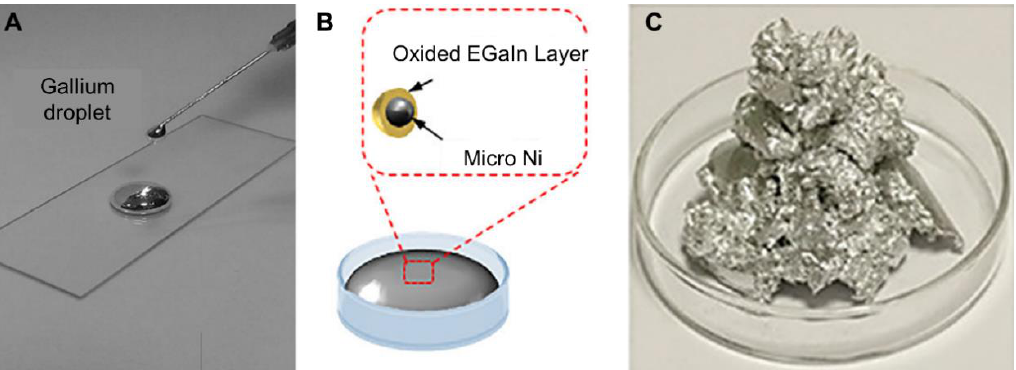
Figure 1. Liquid metal and its mixture. ( A ) Photo of gallium droplet, reproduced with permission from [69]. ( B ) Schematic diagram of Ni-GaIn particle, reproduced with permission from [70]. ( C ) Photo of Cu-GaIn mixure, reproduced with permission from [73].